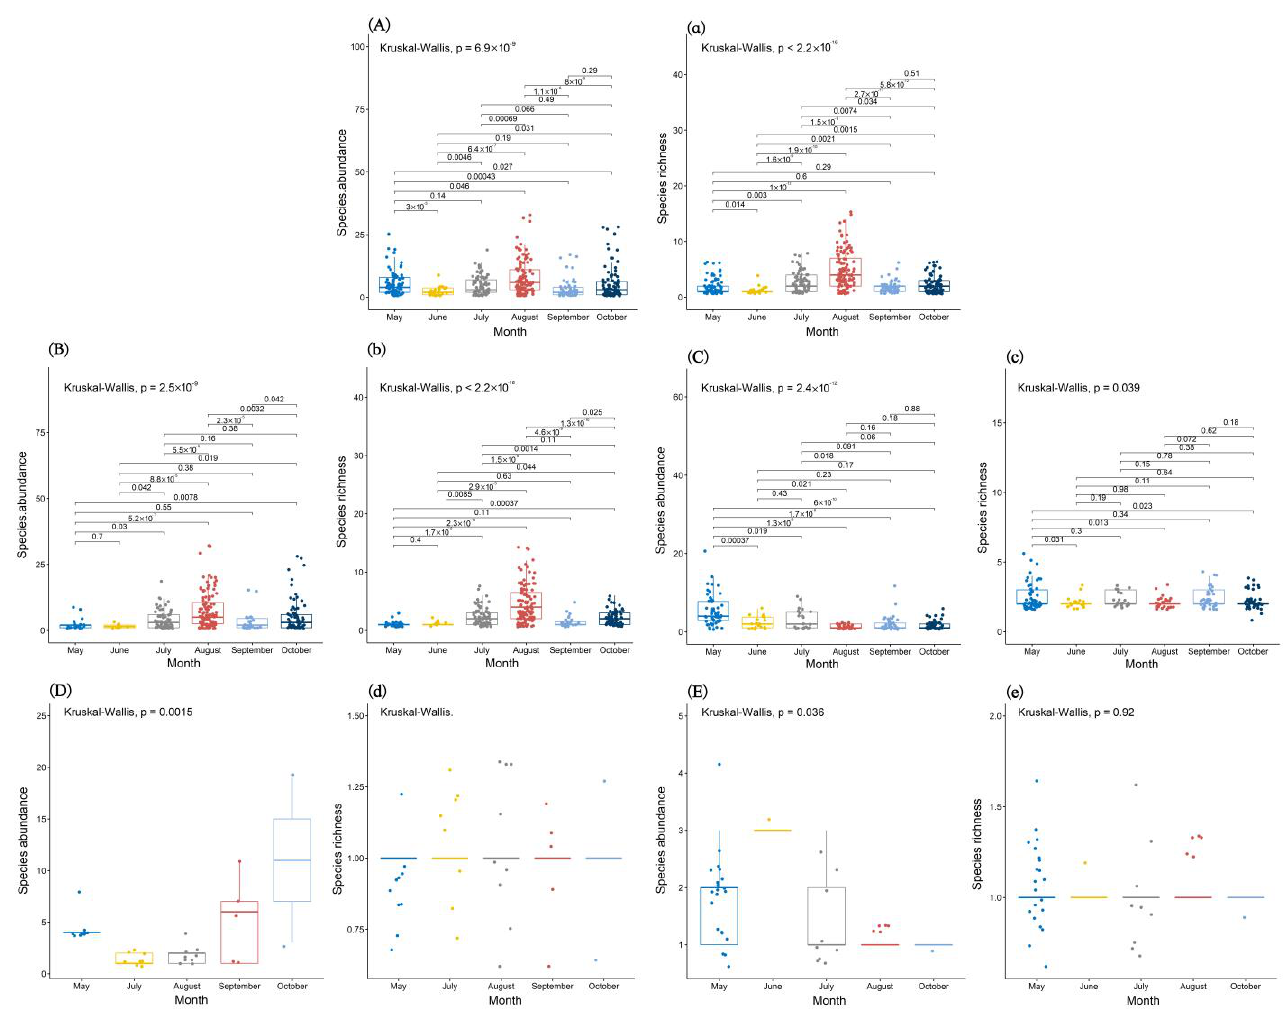
Figure 1. Species’ richness and abundance of all fungal sporocarps ( A , a ), soil fungal sporocarps ( B , b ), rotten-wood fungal sporocarps ( C , c ), litterfall fungal sporocarps ( D , d ), and living-tree fungal sporocarps ( E , e ) in 6 months, as demonstrated by a boxplot diagram. The different colored boxplots represent the species’ richness or abundance of the fungal sporophores in 6 months.